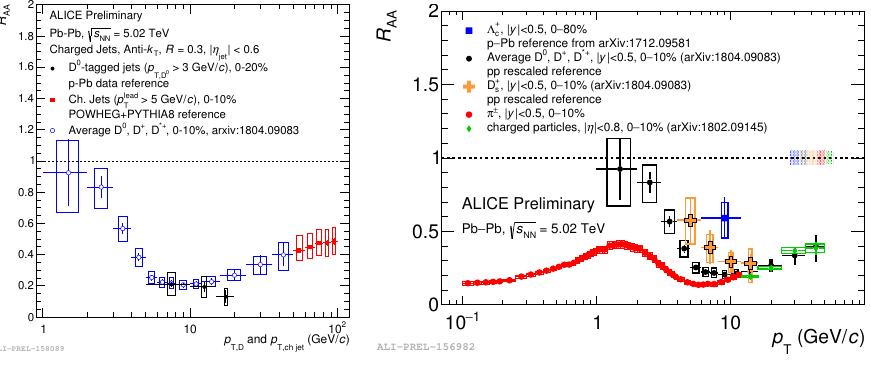
Figure 4. Left: Comparison of the nuclear modification factor for inclusive D-mesons, jet and D-tagged jets in most central Pb–Pb collisions. Right: Comparison of the nuclear modification factor for di ff erent identified particles